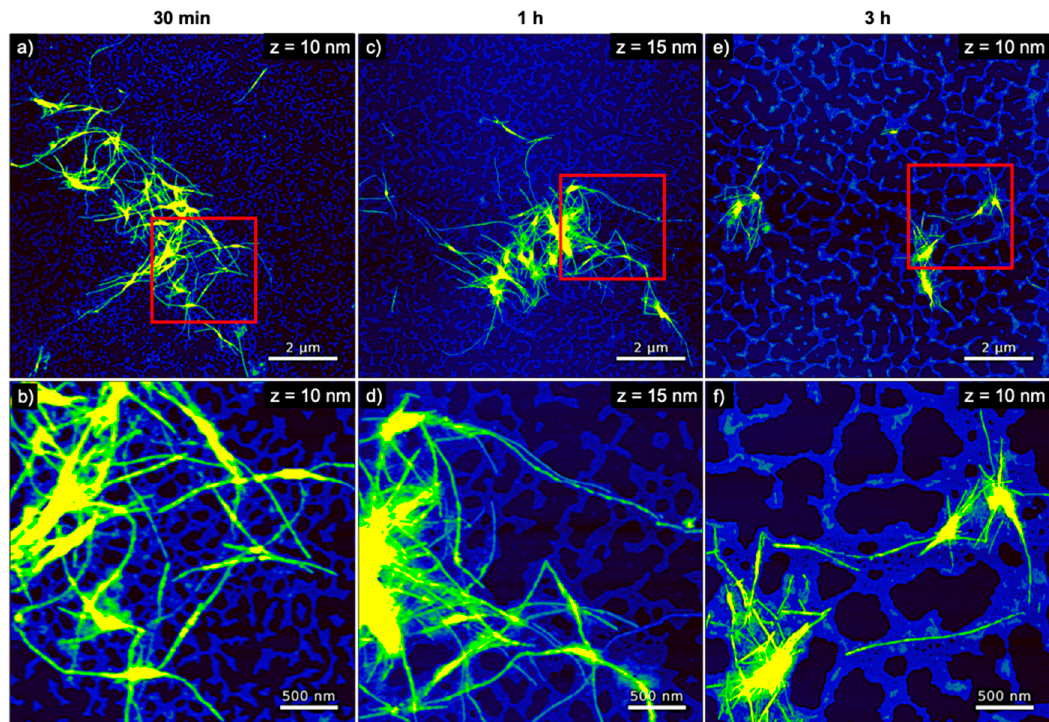
Figure 6. AFM images of hIAPP incubated with DNA origami triangles for ( a , b ) 30 min, ( c , d ) 1 h, and ( e , f ) 3 h. The images in ( b , d , f ) row represent zooms of the regions indicated in the respective images in ( a , c , e ). The ranges of the z-scales are given in the individual image.